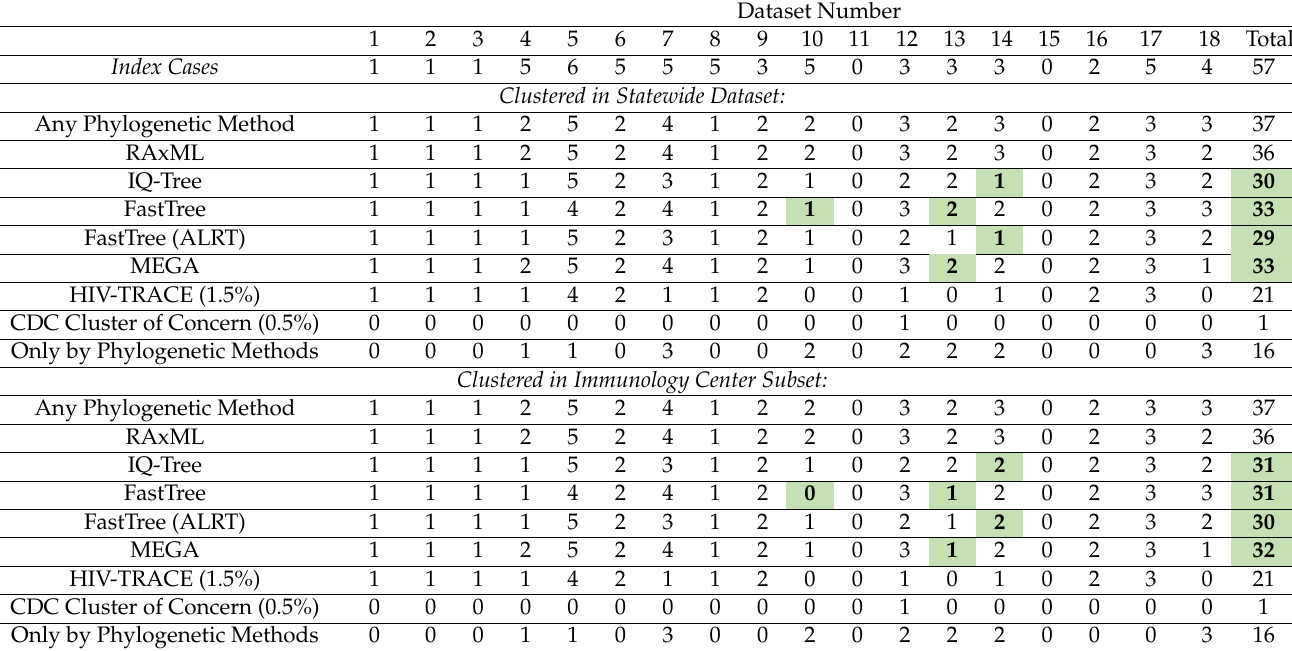
Table 1. Clustering of new HIV cases in RI by dataset number, dataset sampling density (statewide versus Immunology Center), and clustering